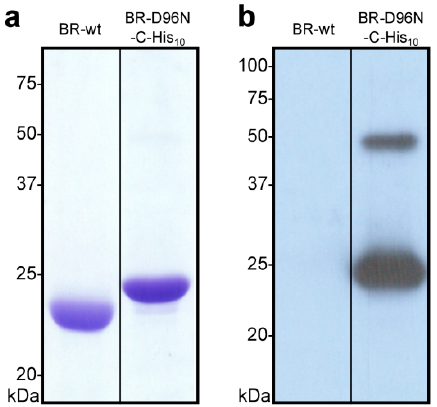
Figure 6. Analysis of BR-D96N-C-His 10 by SDS-PAGE and Western blotting. ( a ) Coomassie Brilliant blue-stained 13.5% SDS/polyacrylamide gel of isolated purple membranes from H. salinarum L33 transformed with BR-D96N-C-His 10 and BR-wt (isolated from H. salinarum S9) as a control. BR-D96N-C-His 10 migrates slower compared to BR-wt, because of the additional His 10 -tag. In each lane, purple membranes corresponding to 10 µg of bacteriorhodopsin were loaded. ( b ) The Western blot analysis of BR-wt and BR-D96N-C-His 10 performed under similar conditions as in ( a ). The primary and secondary antibodies used were mouse monoclonal anti-penta-His antibody (dilution 1:3000) and horseradish peroxidase-conjugated goat anti-mouse antibody (dilution 1:3000), respectively. BR-wt showed no band, due to the absence of a His 10 -tag. BR-D96N-C-His 10 reacted with the anti-penta-His antibody, confirming the presence of the introduced His 10 -tag. A weaker band around 50 kDa, indicates the presence of SDS-resistant BR-D96N-C-His 10 dimers [38,39].